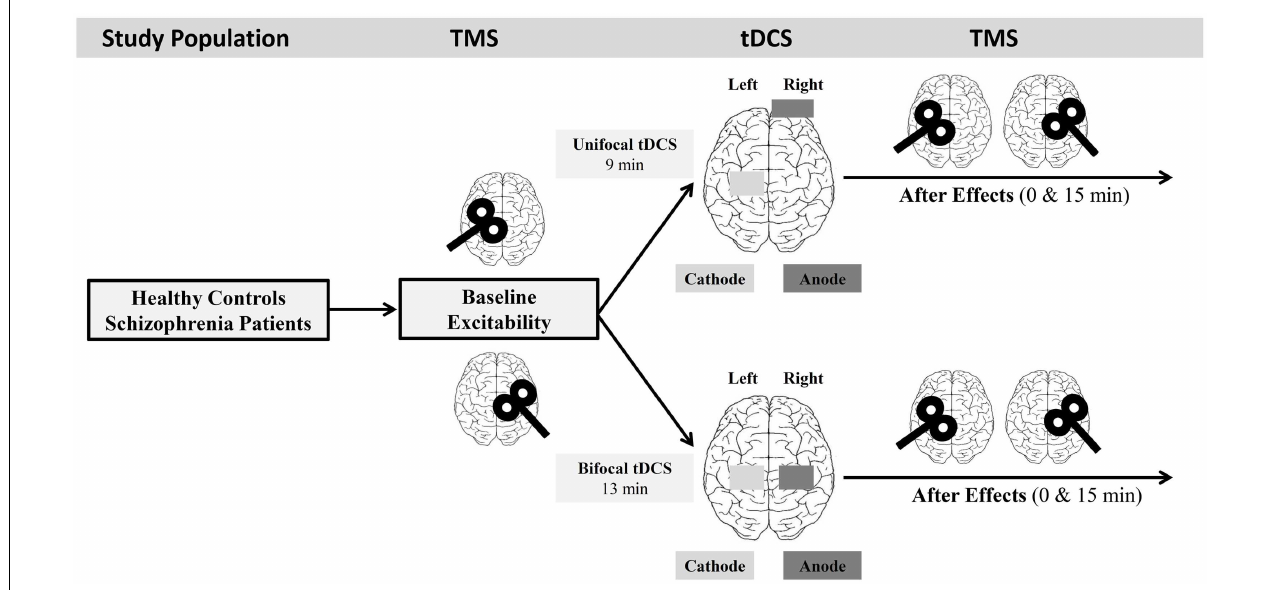
FIGURE 1 | Experimental course and study design . All subjects participated in two experimental sessions (unilateral DCS, bilateral tDCS). Corticospinal excitability was assessed before and after tDCS stimulation on both hemispheres.